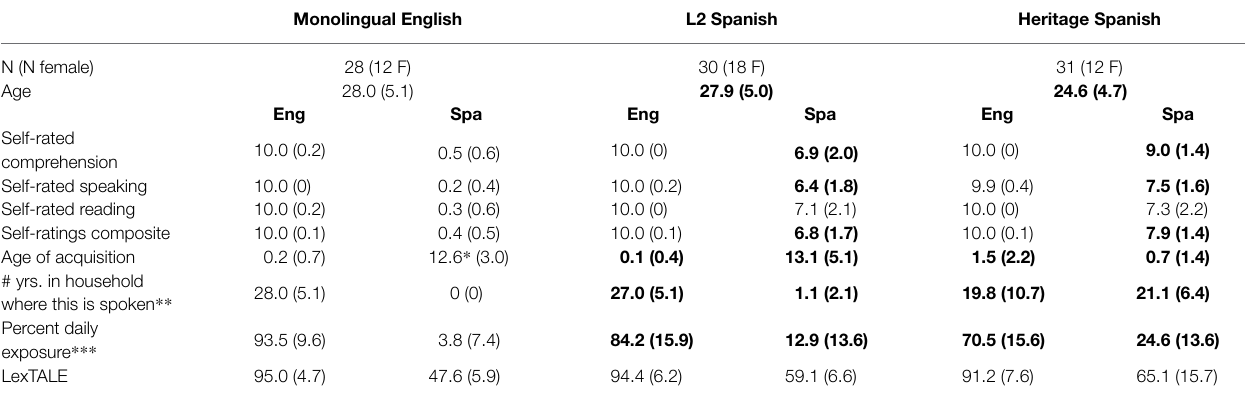
TABLE 1 | Summary of participant characteristics (means and SD